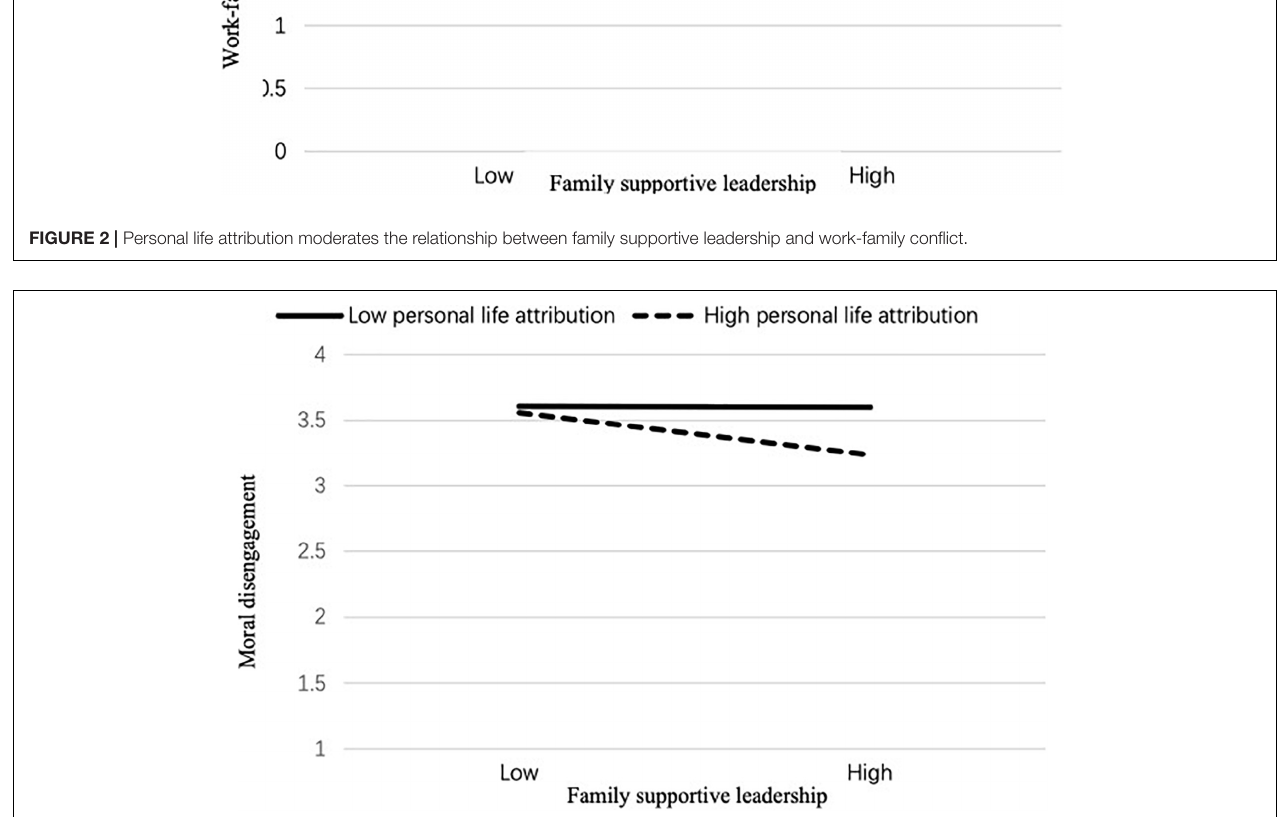
FIGURE 3 | Personal life attribution for family supportive leadership moderates the relationship between family supportive leadership and moral disengagement.